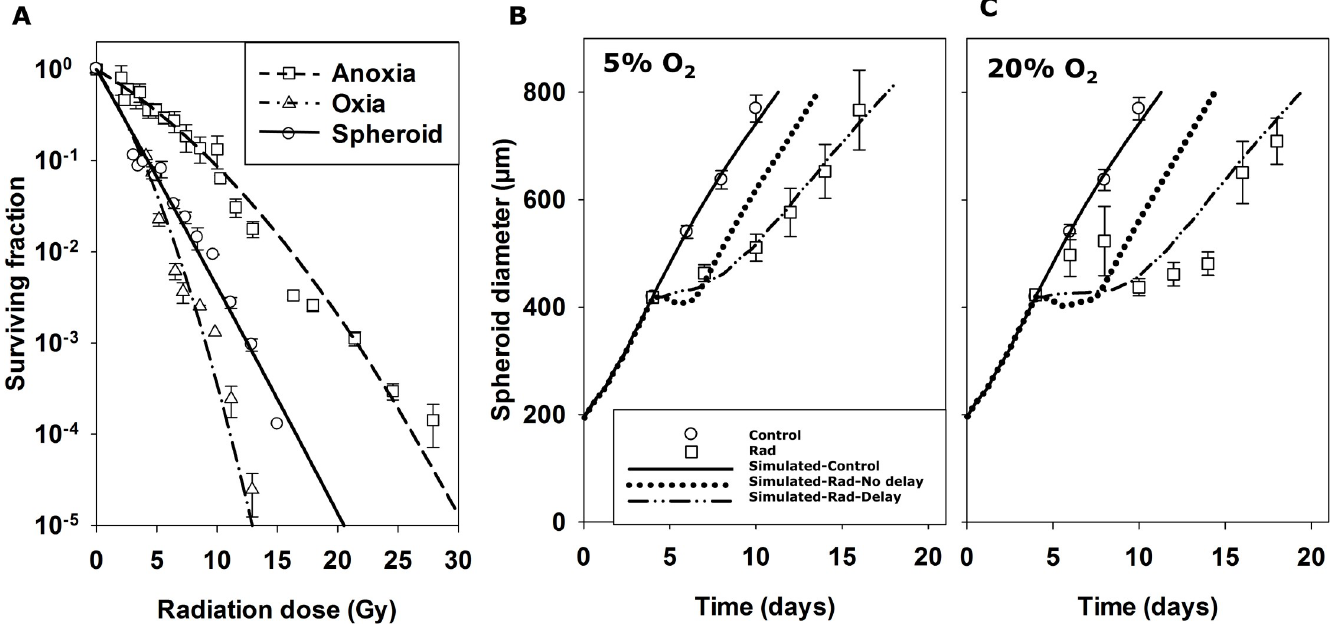
Fig 7. Radiation model and simulation of spheroid response to radiation using the SABM. ( A ) A LQ radiation model was parameterised by measuring clonogenic cell survival of HCT116 monolayer (10 5 cells/mL) in response to a range of radiation doses under anoxic (unfilled rectangles in A , 3 separate experiments) or oxic (unfilled triangles in A , 2 separate experiments) conditions. Values are means ± SEM. Lines represent LQ model fits (Eqn S12) to all monolayer data simultaneously (fitted parameters in Table 1) by minimization of the sum of squared errors between simulated and observed ln(SF). These parameters were used in the SABM to simulate clonogenic cell survival of cells in 4-day spheroids exposed to radiation under 20% O 2 (solid line in A ) and compared to measured clonogenic cell killing in HCT116 spheroids (filled circles in A ). Values are means ± SD (n = 16 spheroids). To compare the measured spheroid growth delay induced by radiation to that predicted by the SABM, HCT116 spheroids were exposed to 4 Gy radiation under 5% (Panel B ) or 20% O 2 (Panel C ) and spheroid growth was monitored as a function of time. Values are means ± SD (n = 16 spheroids) and lines are simulations by the SABM based on clonogenic cell killing alone ( ... ), or with addition of parameters for cell growth inhibition and survival probability at each mitosis following radiation (—) as described in Table